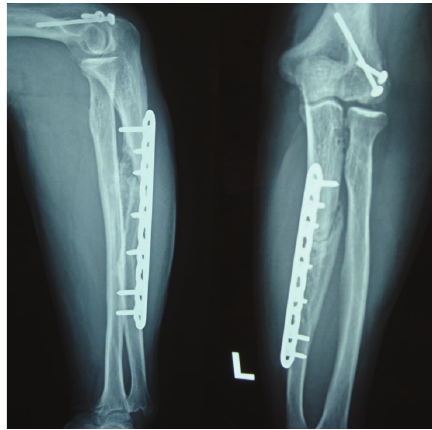
Figure 3: 3-month follow-up X-ray revealing adequate healing.